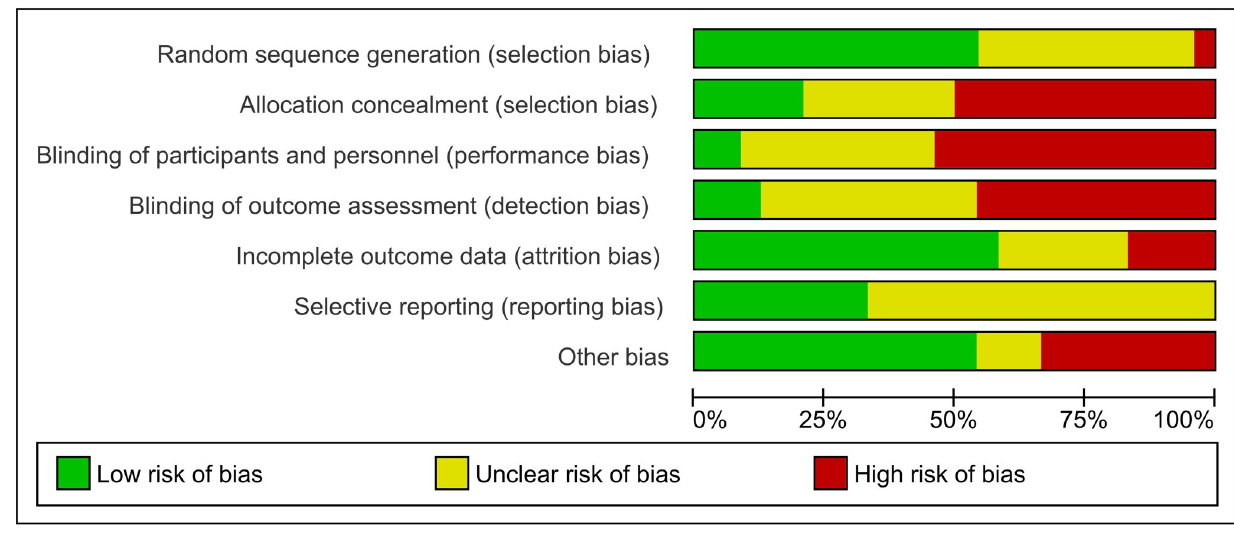
Fig 2. Overview of risk of bias in included